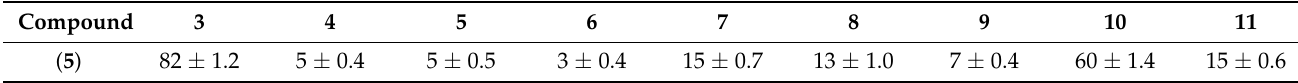
Table 3. Selectivity study of compound ( 5 ) against HDACs 3–11 at 10 µ